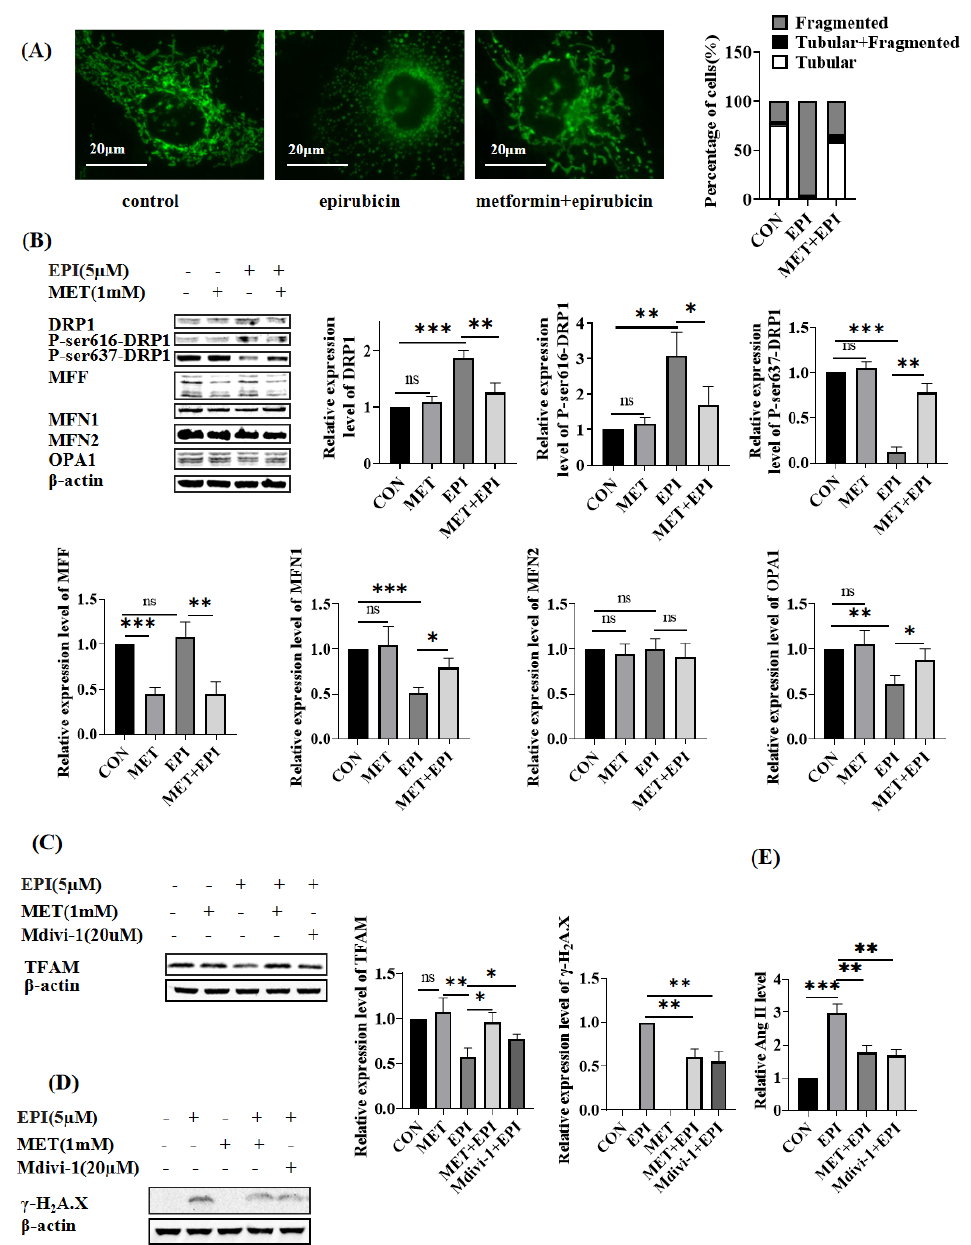
Figure 3. Metformin restores mitochondrial dynamics. ( A ) Mitochondrial morphology analysis by MitoTracker Green. HUVEC cells were treated with 5 µ M epirubicin for 24 h with or without the pretreatment of 1 mM metformin for 12 h. Then, the cells were stained with 100 nM MitoTracker Green at 37 ◦ C in the dark for 30 min and imaged. ( B ) HUVEC cells were treated with 5 µ M epirubicin for 24 h with or without the pretreatment of 1 mM metformin for 12 h. The expression levels of mitochondrial dynamics related proteins were detected by Western blotting. ( C ). HUVEC cells were treated with 5 µ M epirubicin for 12 h with the pretreatment of 1 mM metformin for 12 h or 20 µ M mdivi − 1 for 2 h, respectively. The expression levels of TFAM were detected by Western blotting. ( D ). HUVEC cells were treated with 5 µ M epirubicin for 24 h with the pretreatment of 1 mM metformin for 12 h or 20 µ M mdivi − 1 for 2 h, respectively. The levels of γ − H2A.X were detected by Western blotting. The epirubicin treatment group was used as the reference. ( E ). HUVEC cells were treated with 5 µ M epirubicin for 24 h with the pretreatment of 1 mM metformin for 12 h or 20 µ M mdivi − 1 for 2 h, respectively. The levels of Ang II in the supernatant were measured by ELISA. EPI—epirubicin, MET—metformin, ns—not significant, * p < 0.05, ** p < 0.01, *** p < 0.001.